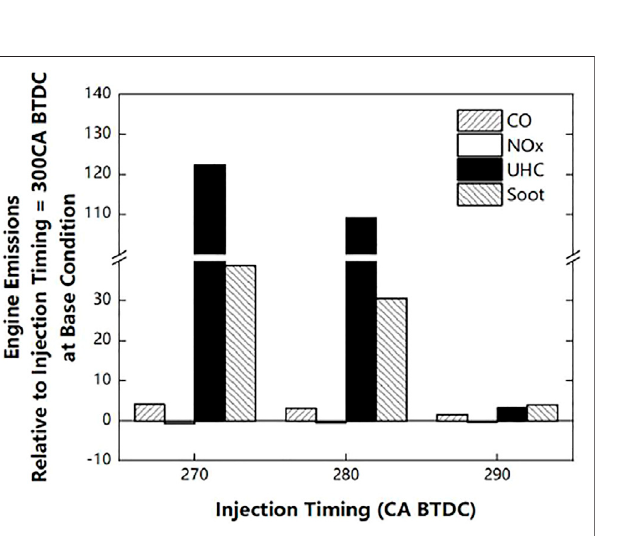
FIGURE 9 | Effect of injection timing on